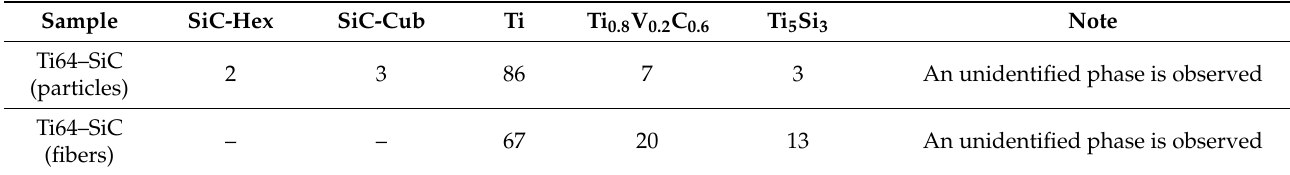
Table 1. Quantitative results